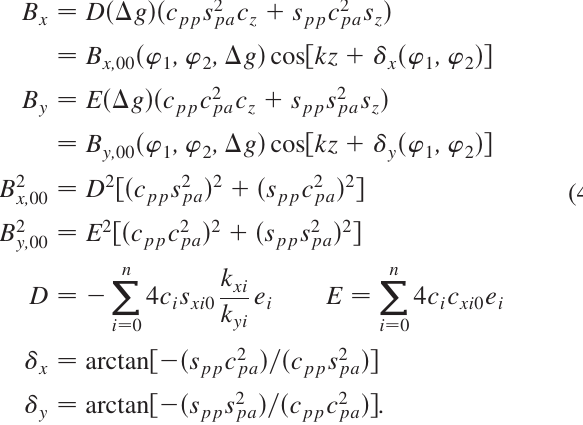
FIG. 3. Accuracy of field prediction from analytic model at large vertical offsets depending on the number of Fourier components used. The magenta curve corresponds to numeric